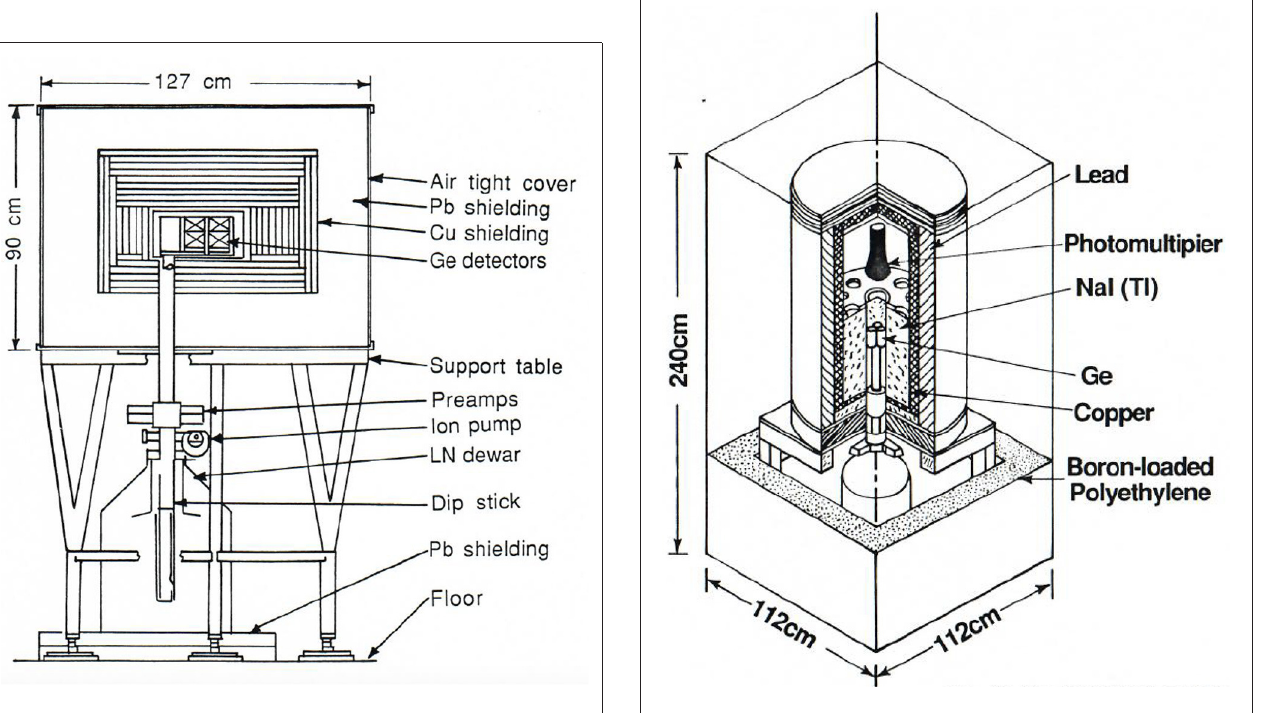
FIGURE 3 | A diagram of the ITEP/Yerevan experiment showing the three crystals, two enriched, and one of natural